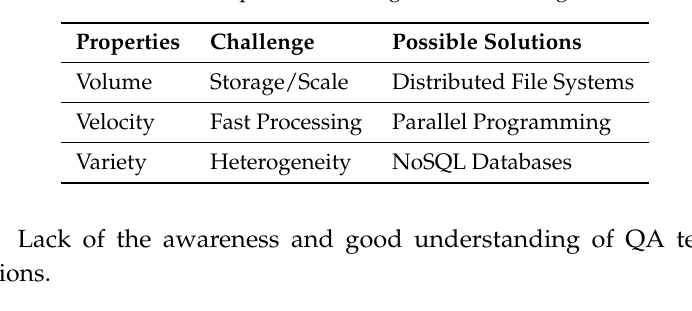
Table 13. Properties, challenges and